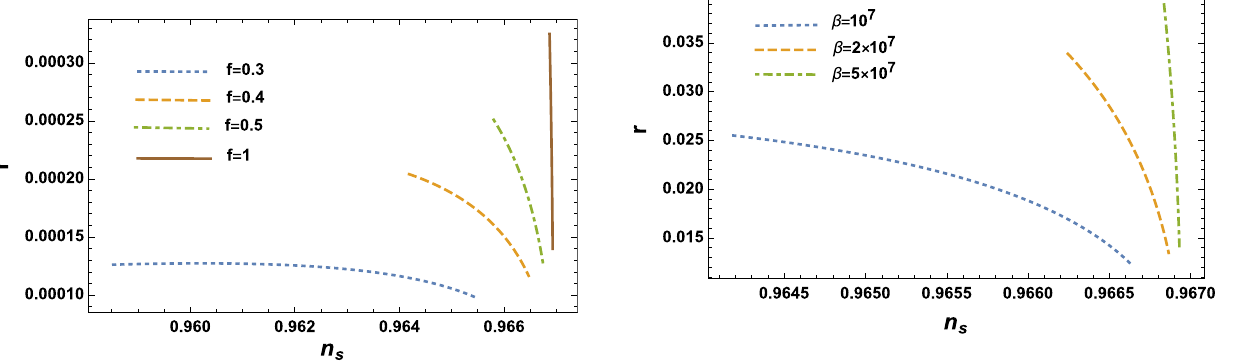
Fig. 4 n s vs r for η in the interval 1 / 4 ≤ η ≤ 1 / 3 for N = 60 and β = 10 7 , 2 × 10 7 , 5 × 10 7 . The scale f for all curves is f = 0 .